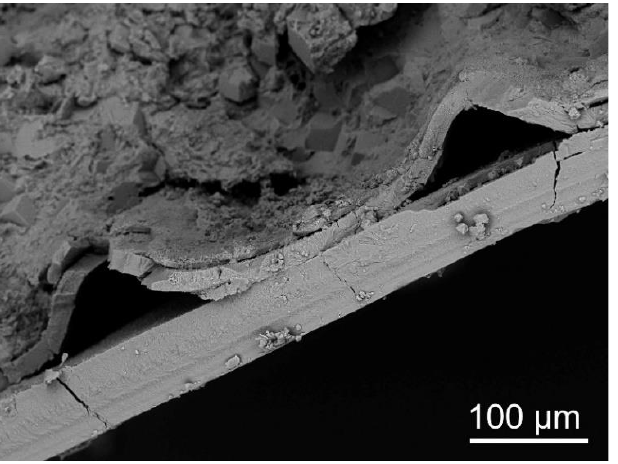
Figure 5. Microlamellar fabric and wrinkled lamella in Sphenothallus sp. from the Carboniferous of Russia.